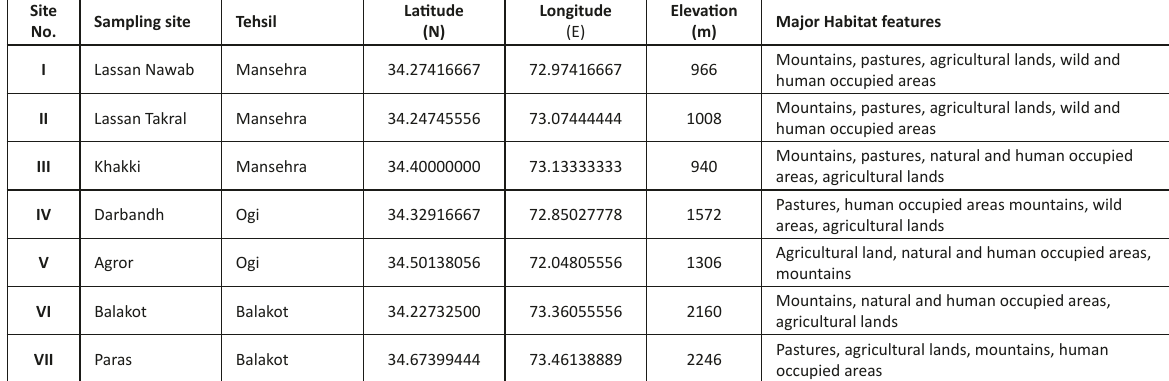
Table 1. Details of seven selected sampling sites in Mansehra District for data collection about distribution, and abundance of Indian Pangolin. Site Sampling No.